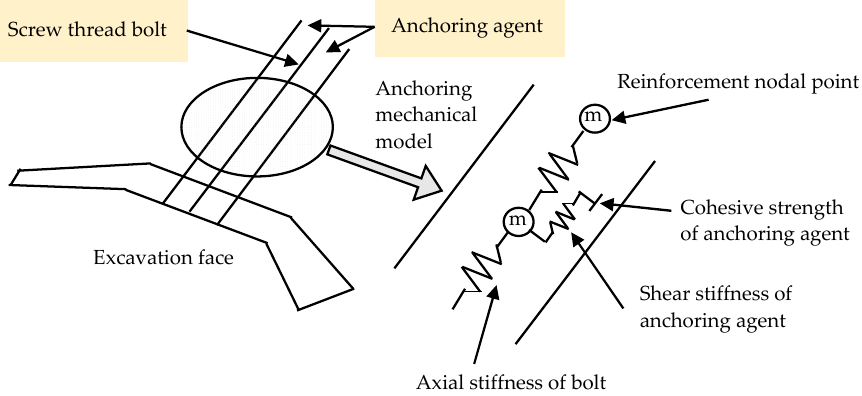
Figure 4. The mechanical representation of the fully anchored reinforcement element system.